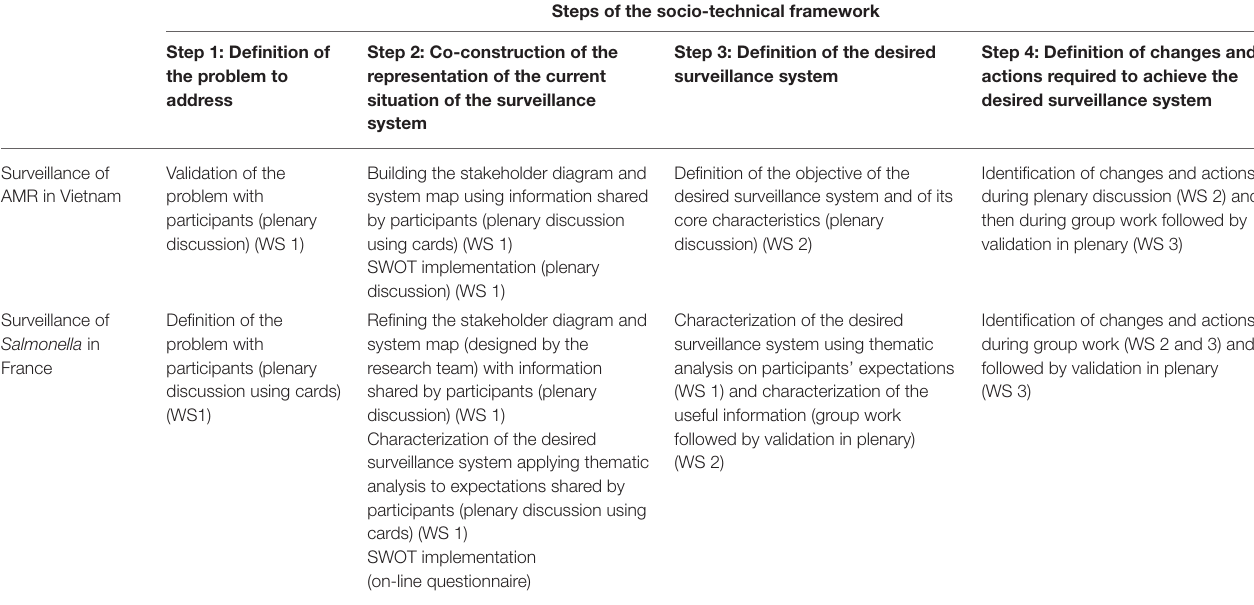
TABLE 1 | Description of the process implementation in Vietnam (surveillance of antimicrobial) and in France (surveillance of Salmonella ). Steps of the socio-technical